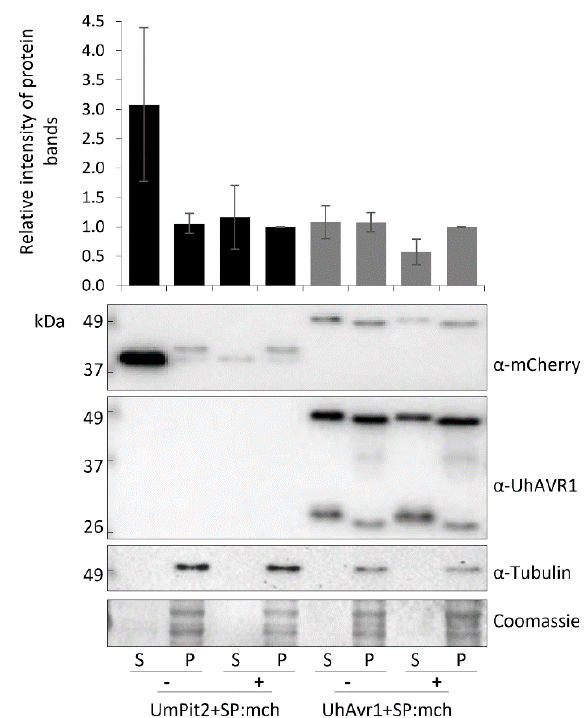
Figure 6. Brefeldin A exposure a ff ects the secretion of UhAVR1 and UmPit2 to liquid medium. Cells of Uh1430 (UhAvr1 + SP:mCherry) and Uh1440 (UmPit2 + SP:mCherry) were grown in liquid medium and exposed to BFA 100 µ g / mL ( + ) or DMSO ( − ) for 4 h. Protein blot analysis of proteins extracted from pelleted cells (intracellular proteins, P) and from spent medium (S) revealed that both e ff ectors were secreted into the medium with secretion reduced upon exposure to BFA ( + ). The predicted sizes are: UmPit2 + SP:mCherry (predicted full length size of 40 kDa and SP-cleaved of 37 kDa), UhAvr1 + SP:mCherry (predicted full length size of 50 kDa and SP-cleaved of 46 kDa). Lower bands (~26 kDa) detected by anti-UhAVR1 antibody represent breakdown products. Experiments were performed three times independently for UmPit2 + SP:mCherry and five times for UhAvr1 + SP:mCherry with similar results. The intensity value of each protein band detected by anti-mCherry antibody was calculated by Image Lab software for each experimental repeat. The graph above the blot depicts the band intensity values which were normalized against the BFA-treated pellet of UmPit2 + SP:mCherry for e ff ector UmPit2, and against the BFA-treated pellet of UhAvr1 + SP:mCherry for e ff ector UhAVR1. The error bars represent the standard deviations calculated for the values from protein blots from three (UmPit2 + SP:mCherry) or five (UhAvr1 + SP:mCherry) experimental repeats.